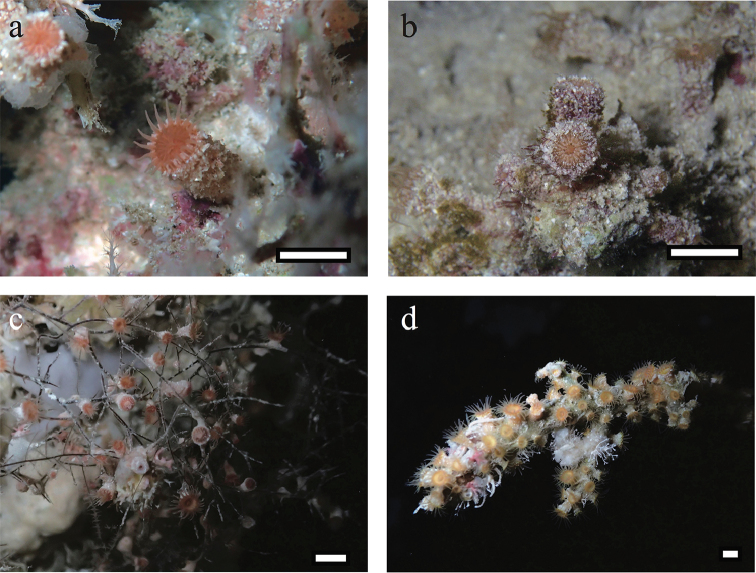
Polyp images of Antipathozoanthus
obscurus sp. n., A.
remengesaui sp. n. and A.
cavernus sp. n. in situ. a
A.
obscurus sp. n. . NSMT-Co1602 (MISE-BISE1), Collected from Cape Bise, Motobu, Okinawa-jima Island, Japan (26°42'34.4"N, 127°52'49.2"E) at a depth of 5 m by JDR, 14 August 2014. b
A.
obscurus sp. n., closed polyp with heavy encrustion by various fine sand particles. MISE-TF54, collected from Cape Zanpa, Yomitan, Okinawa-jima Island, Japan (26°26'26.5"N, 127°42'43.7"E) at a depth of 3 m by TF, 6 April 2009. c
A.
remengesaui sp. n., colony connected by poorly developed coenenchyme with white polyps on Antipathes sp. NSMT-Co1603 (MISE-PALAU2) collected from Blue Hole, Palau (7°8'29.4"N, 134°13'23.3"E) at a depth of 23 m by JDR, 15 September 2014 d
A.
cavernus sp. n., polyp connected by highly developed coenenchyme with orange ring around oral disk. RMNH.Coel.42322 (MISE-PALAU5) collected from Siaes Tunnel, Palau (7°18'54.8"N, 134°13'13.3"E) at a depth of 39 m by JDR, 1 September 2014.